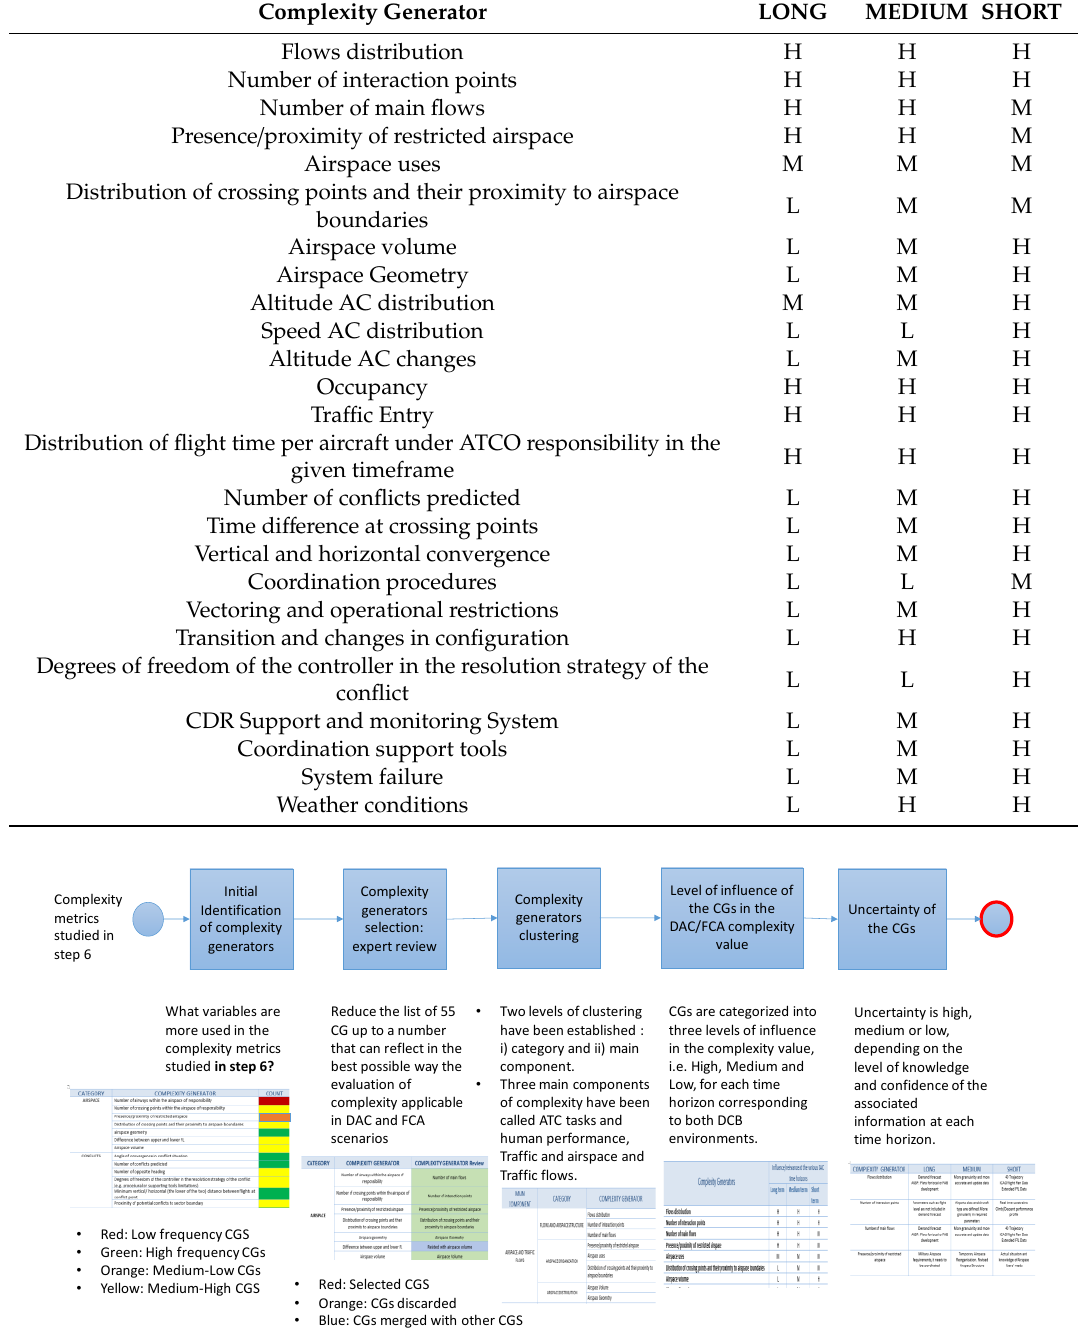
Figure 4. Extracting the Complexity Generators (CGs).